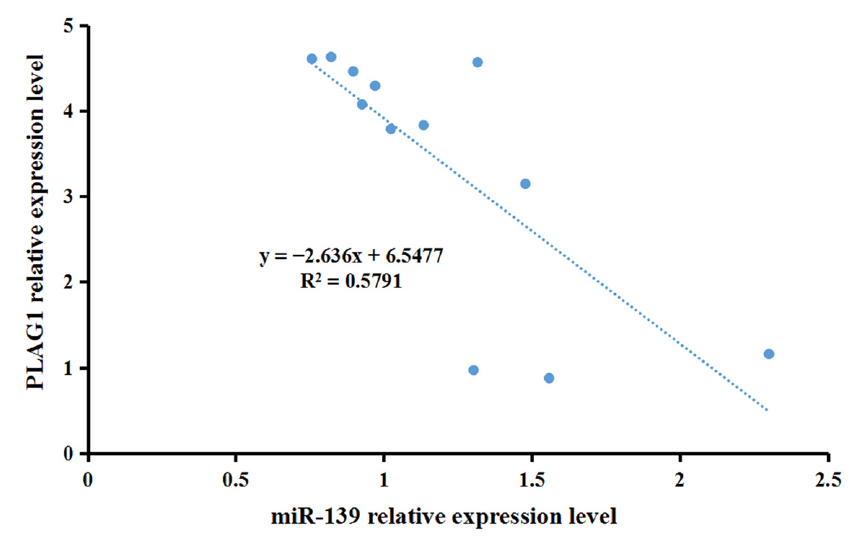
Figure 5. Negative correlation between miR-139 expression and PLAG1 gene expression in fetal ovine muscle tissues.